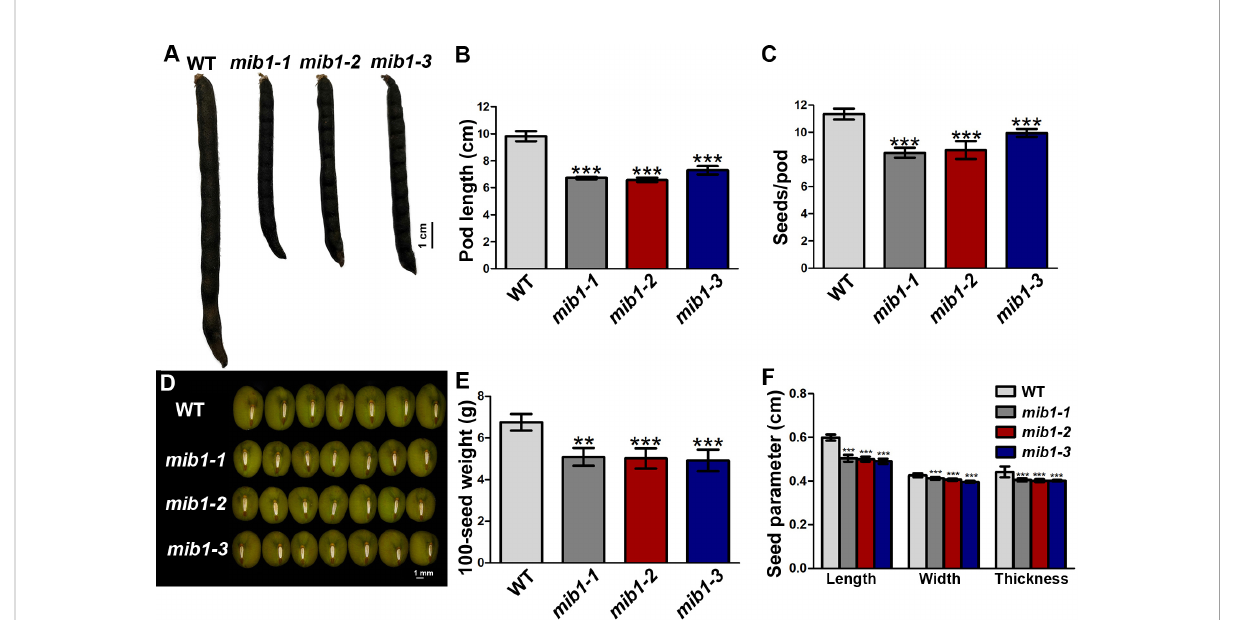
FIGURE 2 Characterization of pods and seeds of WT and mib1 mutants. (A) Pods of WT and mib1 mutants at matured stage. (B) Pod length of WT and mib1 mutants ( n = 150). (C) Seed number per pod of WT and mib1 mutants ( n = 150). (D) Seeds of WT and mib1 mutants. (E) The 100-seed weights of WT and mib1 mutants ( n = 5). (F) Seed parameters of WT and mib1 mutants ( n = 200). The data were means ± SD. The Tukey ’ s multiple comparison test was used. ** p < 0.01, *** p <